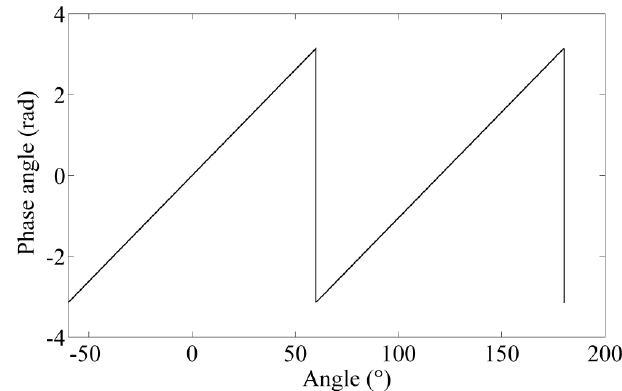
Figure 3. Linear phase angle changes vs. angle